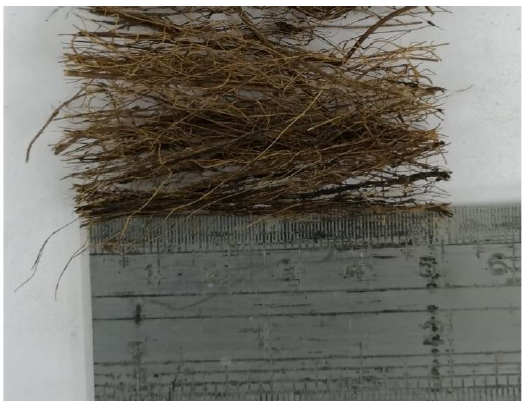
Figure 2. SDPMFs after preparation. Table 1. Chemical composition and physical properties of SF.